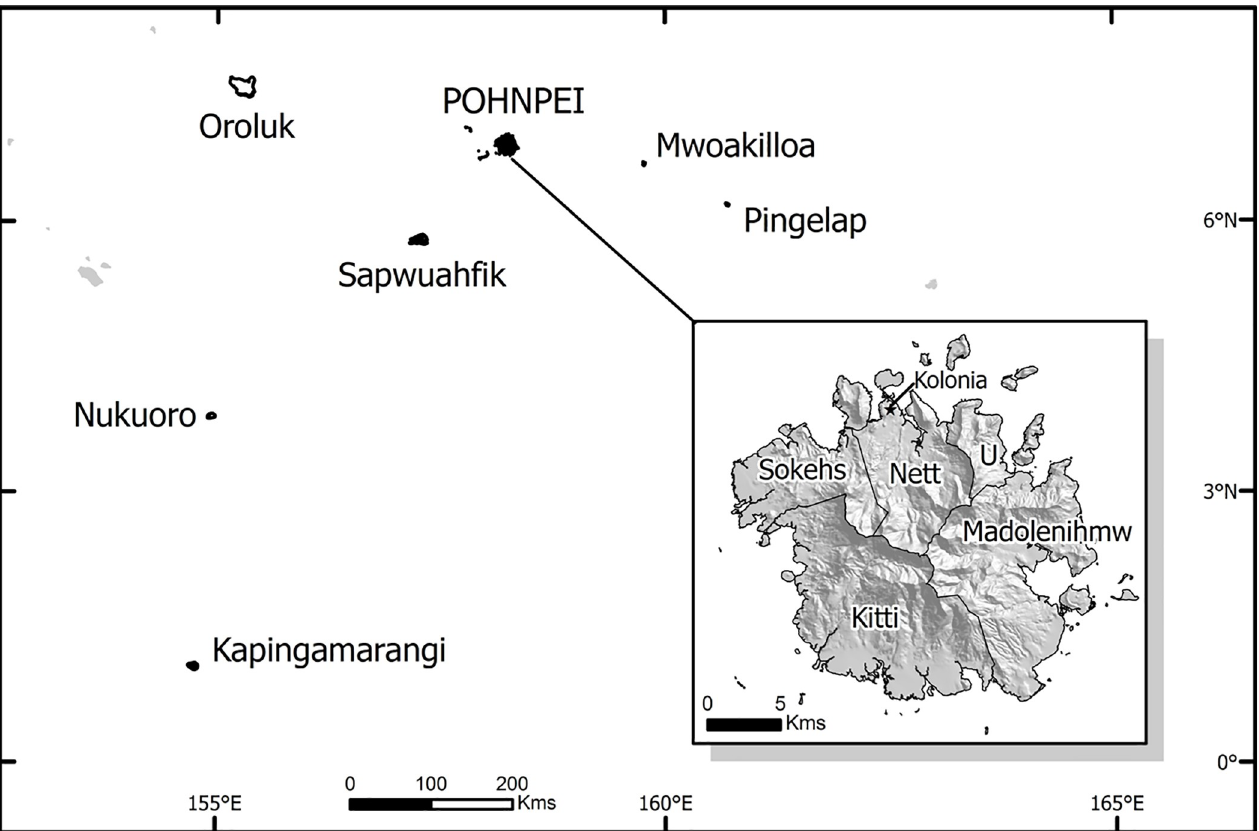
Fig 1. Map of Pohnpei including Pohnpeian atolls. This map shows the island state of Pohnpei and its surrounding atolls. The inset image shows the five municipalities or kingdoms of Pohnpei and the capital, Kolonia. Map courtesy of Hannah Stevens, Geographic Information Systems Laboratory, The New York Botanical